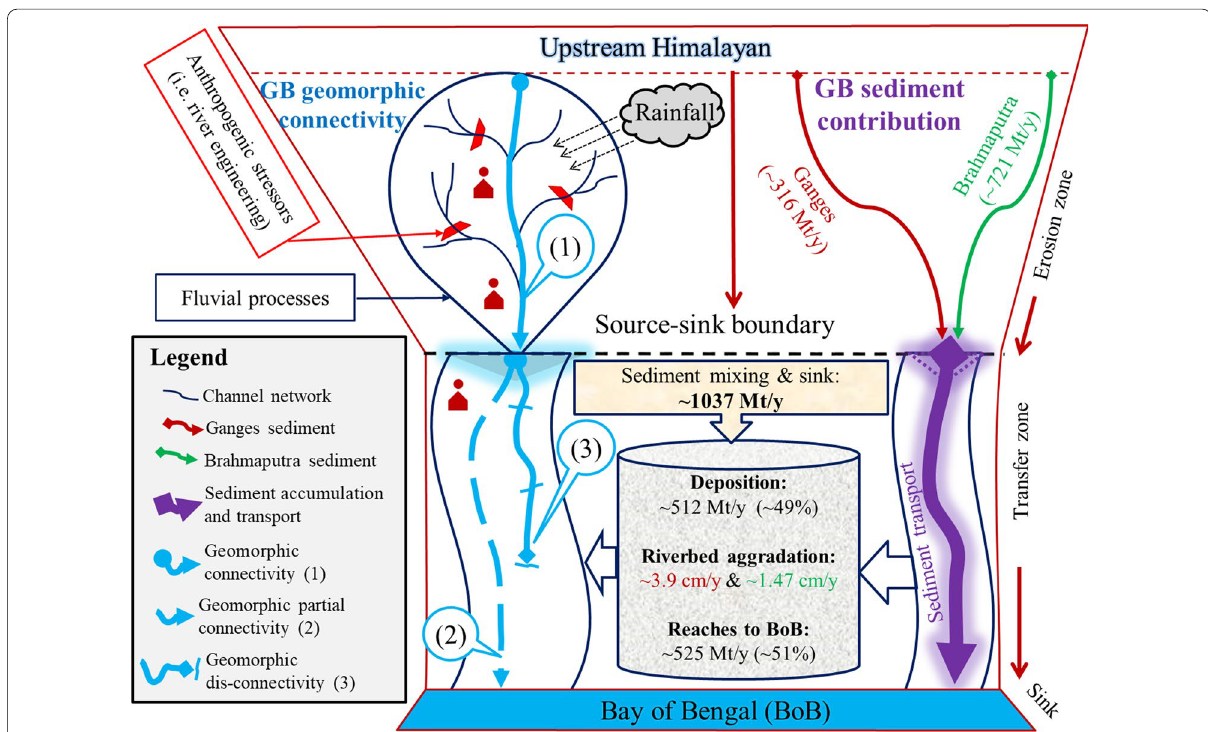
Fig. 5 A conceptual diagram showing the geomorphic connectivity from the Himalayan upstream to the BoB based on the existing literature (Goodbred and Kuehl 1999; Islam et al. 1999, 2001; Wasson 2003; Garzanti et al. 2011; Jain et al. 2012; Dietrich et al. 2020). On the right side, sediment contribution from upstream two major basins is shown. On the left side, the connected (1) and partially connected (2) or disconnected (3) geomorphic systems are visualized from source to sink areas. The fluvial sedimentation processes (i.e., excessive sediment sequestering, riverbed aggradation) and anthropogenic stressors (i.e., river engineering, barrage, and dam construction) may change the geomorphic connectivity in the GBM river system. The altering geomorphic connectivity from connected to partially connected or disconnected, impeded by sediment trapping, may significantly impact the GBM river’s hydro-geomorphic system. Mt/y denotes the million tons per